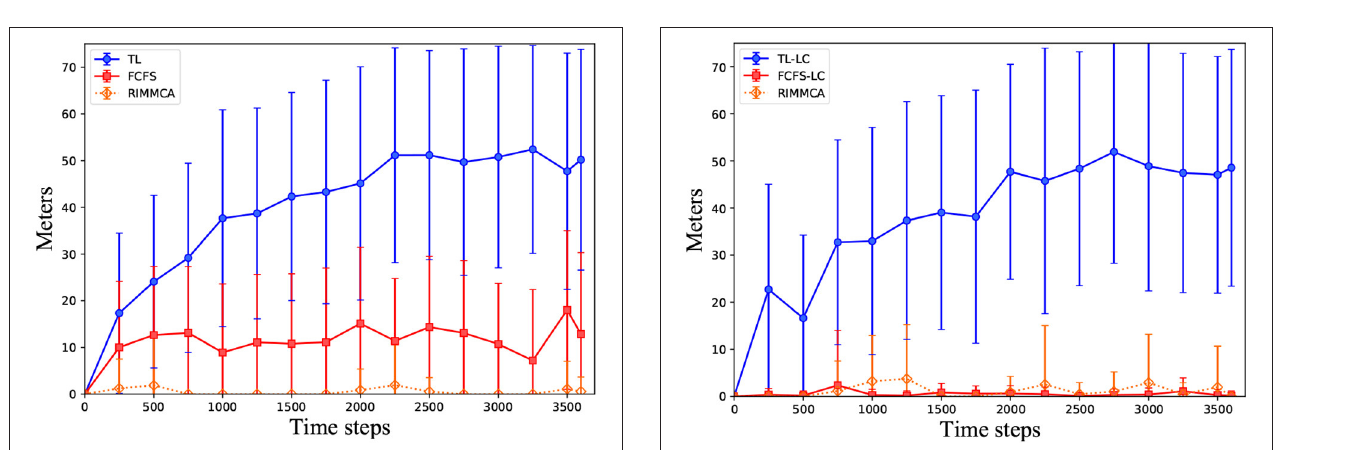
also repeated more than 20 runs. The values reported below are